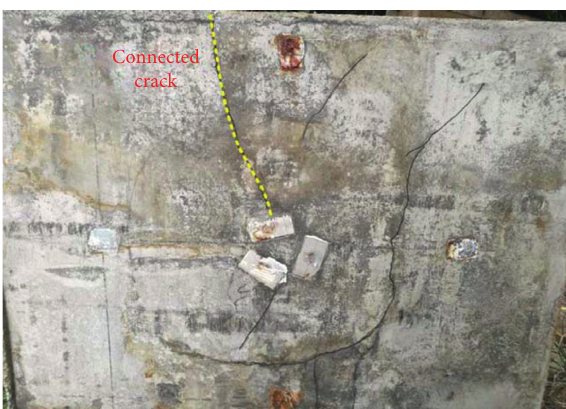
Figure 8: A blasting crater at the bottom of the parent body in Model